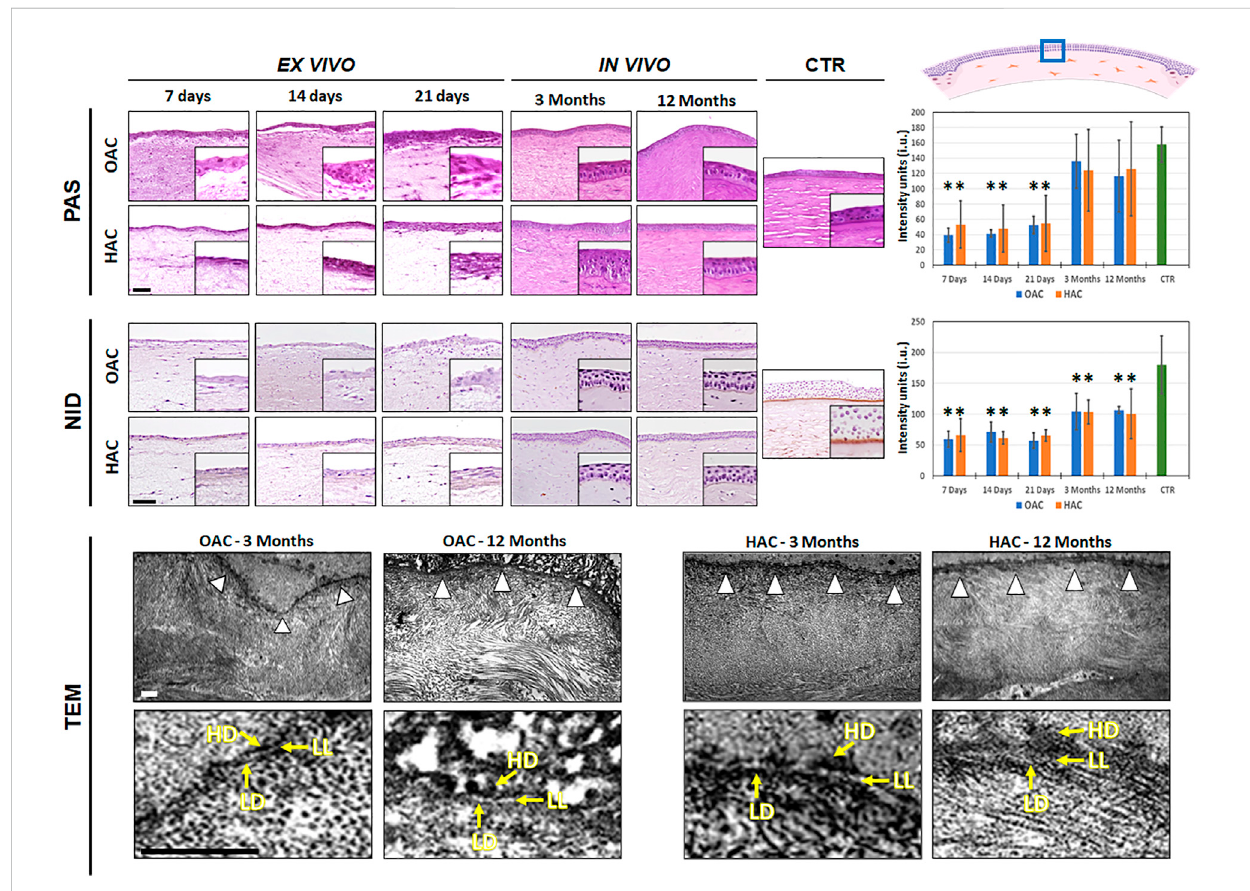
FIGURE 5 Analysis of the basement membrane in orthotypical (OAC) and heterotypical (HAC) arti fi cial corneas and controls. PAS: periodic acid of Schiff histochemistry for glycosaminoglycans of the basement membrane; NID: nidogen-1 immunohistochemistry. In both cases, the area in which the in vivo histological images were obtained is labeled with a blue square in the illustration representing the rabbit cornea shown at the upper right corner. TEM: transmission electron microscopy with white arrowheads pointing to the basement membrane and yellow arrows highlighting the presence of the lamina lucida (LL), lamina densa (LD) and hemidesmosomes (HD). Bioarti fi cial corneas kept ex vivo for 7, 14 and 21 days, and corneas grafted in vivo for 3 and 12 months are shown for the histochemistry and immunohistochemistry analyses. Controls (CTR) correspond to native, normal human corneas. Scale bars: 50 µm for the histochemistry and immunohistochemistry and 1 µm for the TEM analysis (applicable to all images). Histograms to the right correspond to the quantitative analysis of PAS and NID signal intensity quanti fi ed in intensity units (i.u.) of the ImageJ